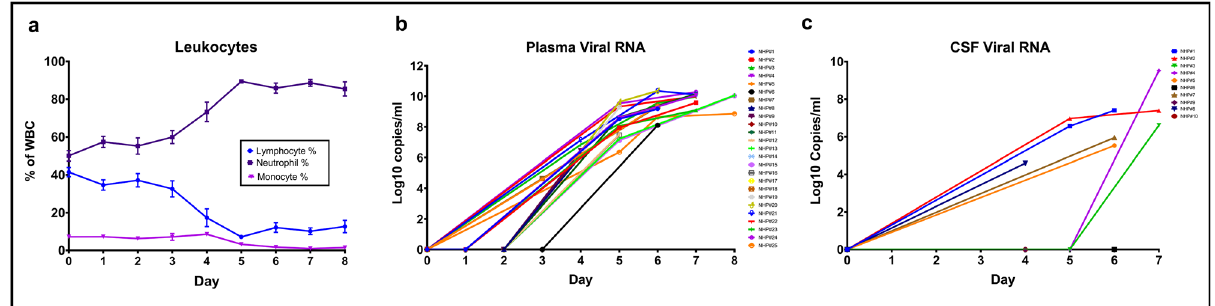
Fig. 1 Complete blood counts, plasma and CSF viral loads in infected animals. a Percent lymphocytes, neutrophils and monocytes in the blood of all animals ( n = 25 animals) over the course of the disease. b Plasma viral load values for all animals ( n = 25 animals) over the course of the disease. c CSF viral load values for group A animals ( n = 10 animals) over the course of the disease. Data are presented as mean values + / − standard error of the mean (SEM). Source data are provided as a Source Data fi